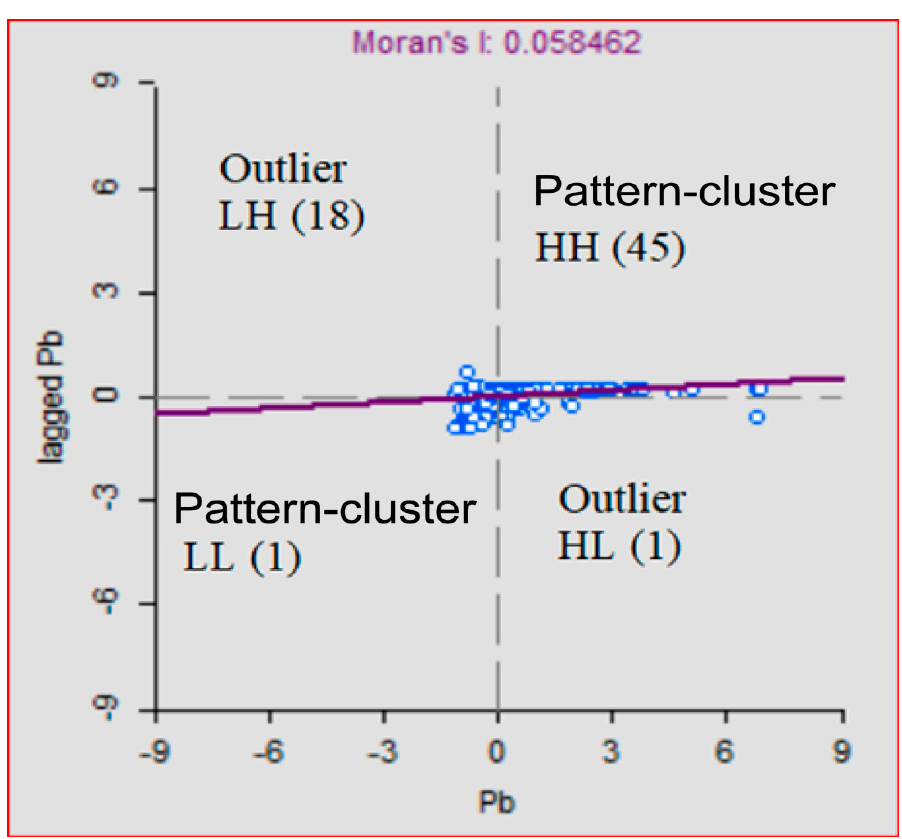
Figure 2. Univariate Local Moran’s I scatter plots at 12905 m threshold distance of soil